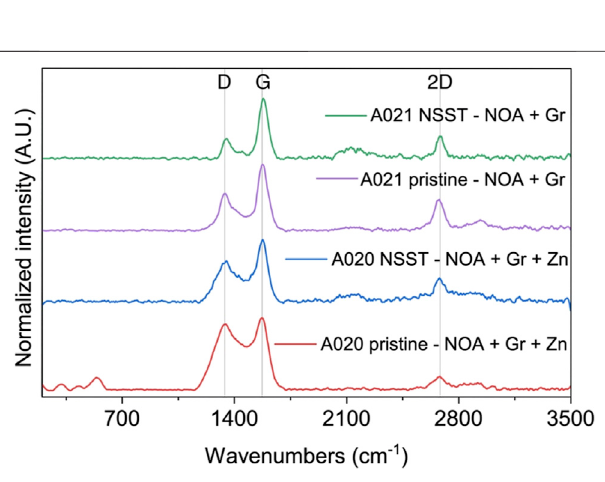
Frontiers in Materials |